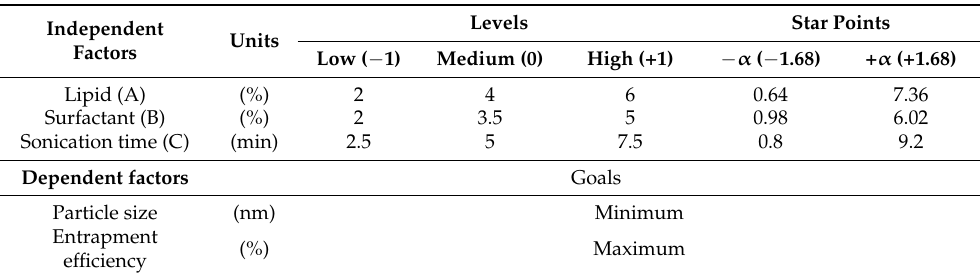
Table 1. Independent factors and their levels with the dependent factors used in the central composite design.